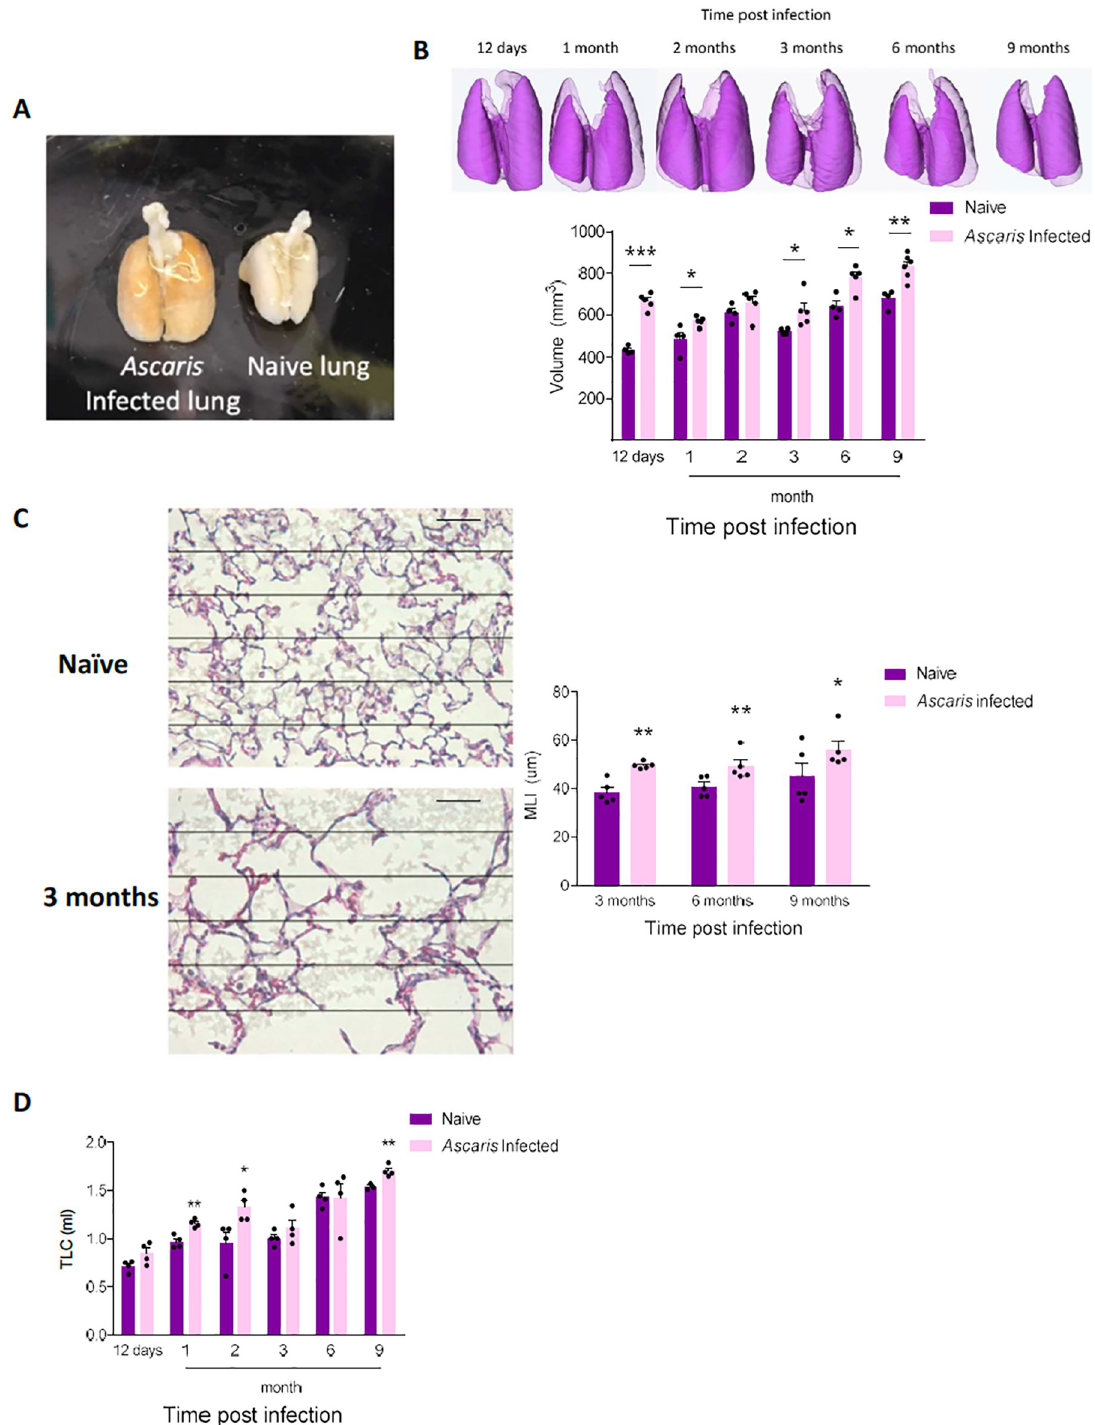
Fig 2. Ascaris suum induces chronic lung disease. Mice were challenged with Ascaris suum at standard time intervals as previously described. (A) Gross appearance of lungs from age- and sex-matched Ascaris challenged mice and PBS na ï ve mice at day 12 post- infection (p.i.) demonstrating visibly larger lungs in the Ascaris challenged mouse (B) Representative 3-D reconstruction and post- expiratory aerated lung volume from Ascaris challenged mice and PBS na ï ve mice was calculated using micro computed tomography (microCT) at standard intervals p.i. and (C) Mean linear intercept (MLI) calculation from lung histology of mice p.i. compared to PBS na ï ve control mice at 3 months, 6 months and 9 months p.i.. Sections of lungs were specifically selected based on larval transition